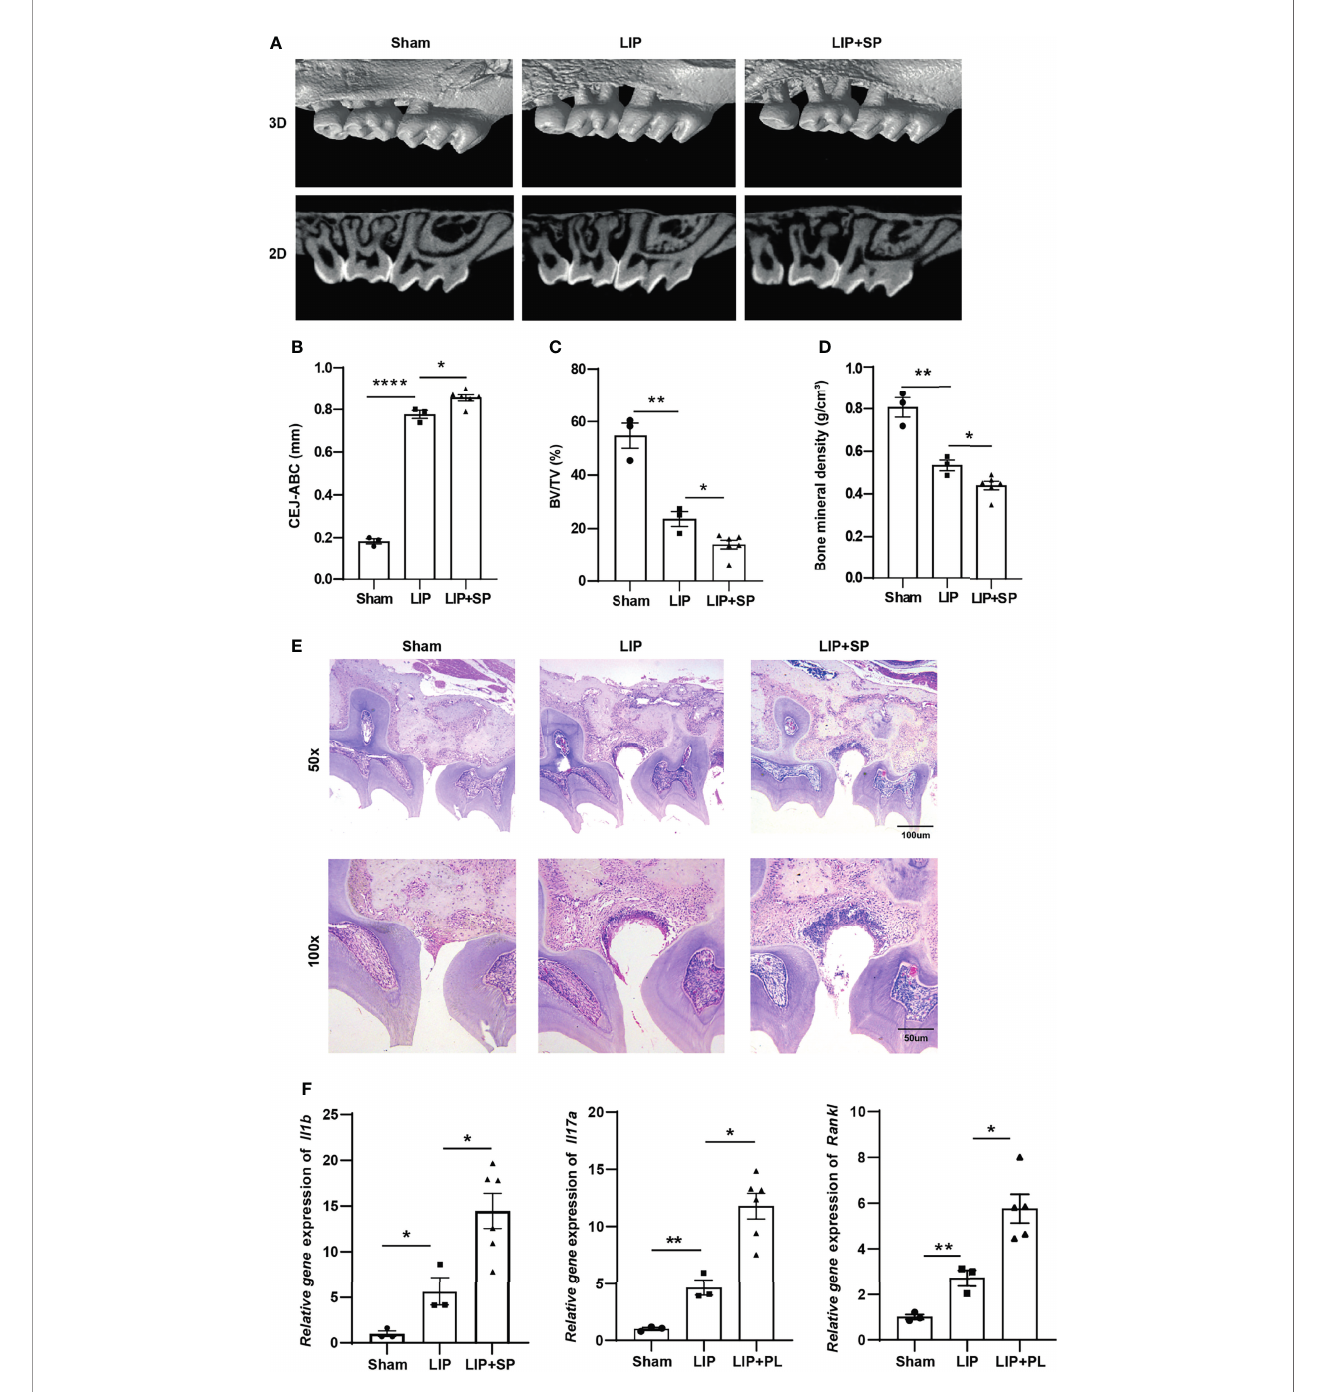
FIGURE 4 | Transplantation of human periodontitis-associated bacteria worsens periodontitis in mice. (A) Representative images of Micro – computed tomography scanning of left maxilla from the indicated groups of mice. Both three-dimensional volume (Upper panels) and multiplanar reconstruction (Lower panels) are shown. (B) Quanti fi cation of the distance from cementoenamel junction (CEJ) to alveolar bone crest (ABC). (C) The ratio of bone volume (BV) to total volume (TV) of maxilla surrounding the second molar. (D) Bone mineral density (BMD) (g/cm 3 ) of maxilla surrounding the second molar. (E) Representative hematoxylin – eosin (H&E) staining images of periodontal tissue showing the pathogenic alteration. (F) QRT-PCR analyses of in fl ammatory and osteoclastogenesis gene expression. Gapdh was used as internal references. The values represent means ± SEM (n = 3:3:6) from three independent experiments. ns, not signi fi cant. *P < 0.05, **P < 0.01, ****P <